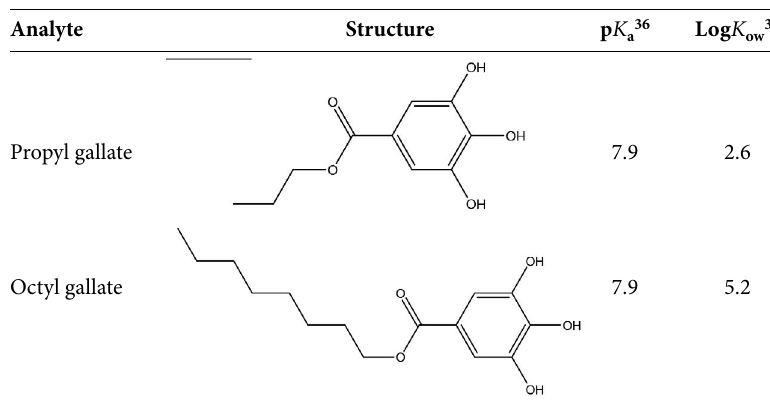
Table 1. Chemical structure and properties of the selected alkyl